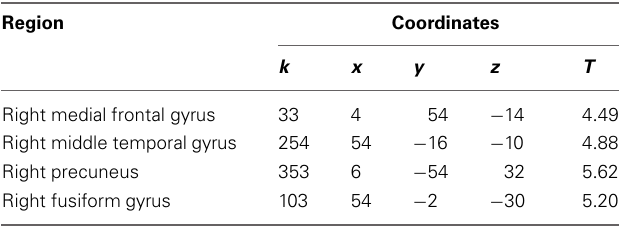
Table 3 | Coordinates and peak activation statistics for clusters in familiar other—self